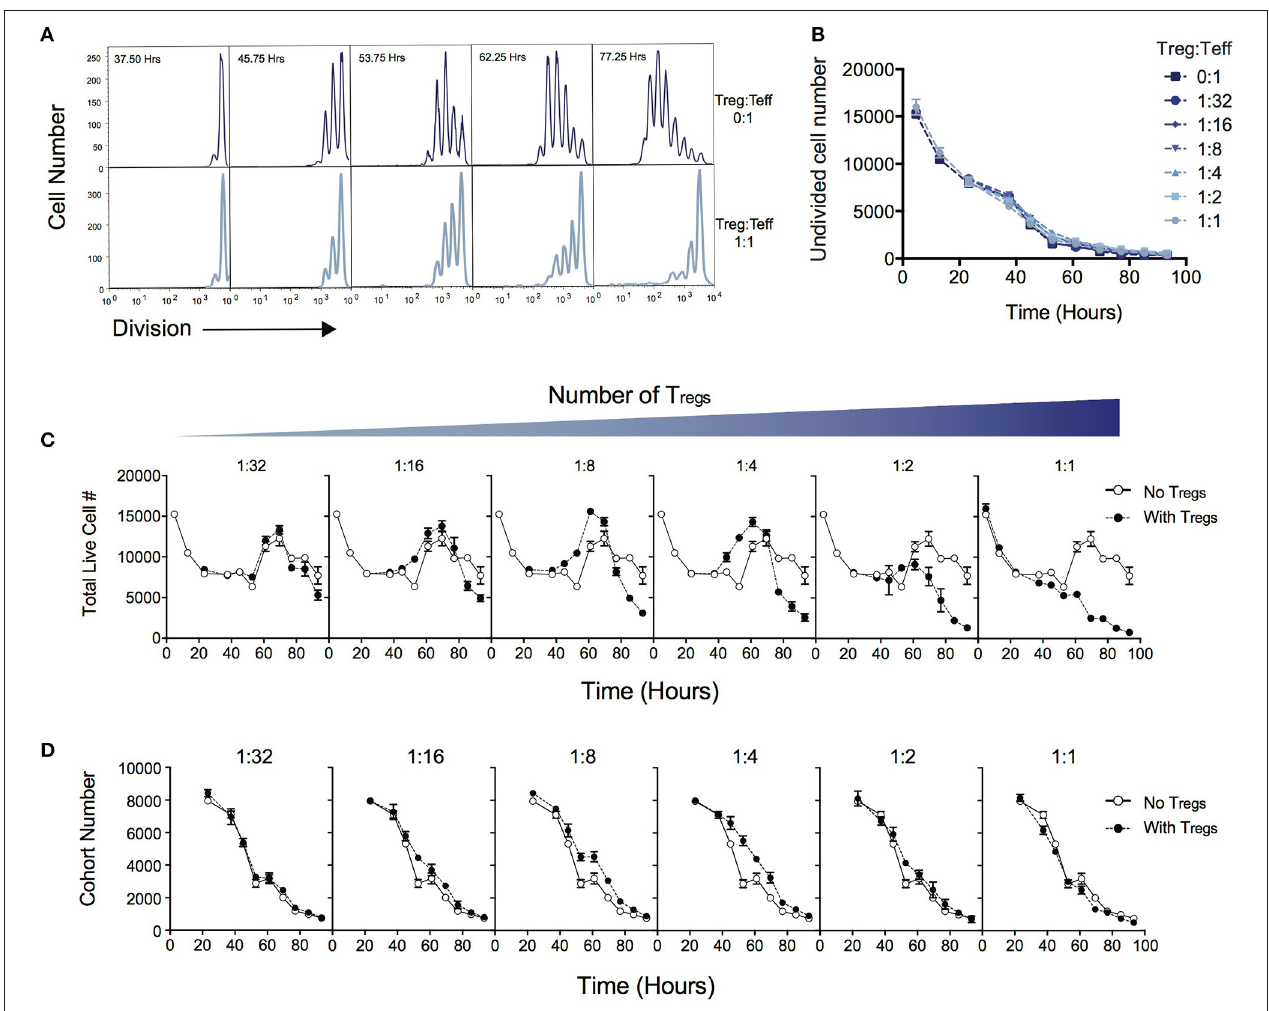
FIGURE 1 | Quantitative analysis of the effect of Tregs on Teff stimulation. CD4 + CD25 − CD62L + effector T cells (Teffs) labeled with cell division dyes were co-cultured with varying ratios of Tregs and the response measured. (A) Example timecourse of cell division progression in cultures without Tregs (top panel) and with Tregs (lower panel). (B) Number of undivided Teff cells in culture over time. Data shown are mean + /– SEM of triplicate samples. One representative data set from three independent experiments is shown. (C) The effect of Tregs on the total live cell number of Teffs over time for varying ratios of suppression is shown. For each graph, the Treg ratio (closed circles) is overlaid with the control culture with no Tregs added (open circles). (D) The cohort number over time of Teff cells is shown for varying ratios of Tregs. For each graph, the Treg ratio (closed circles) is overlaid with the control culture with no Tregs added (open